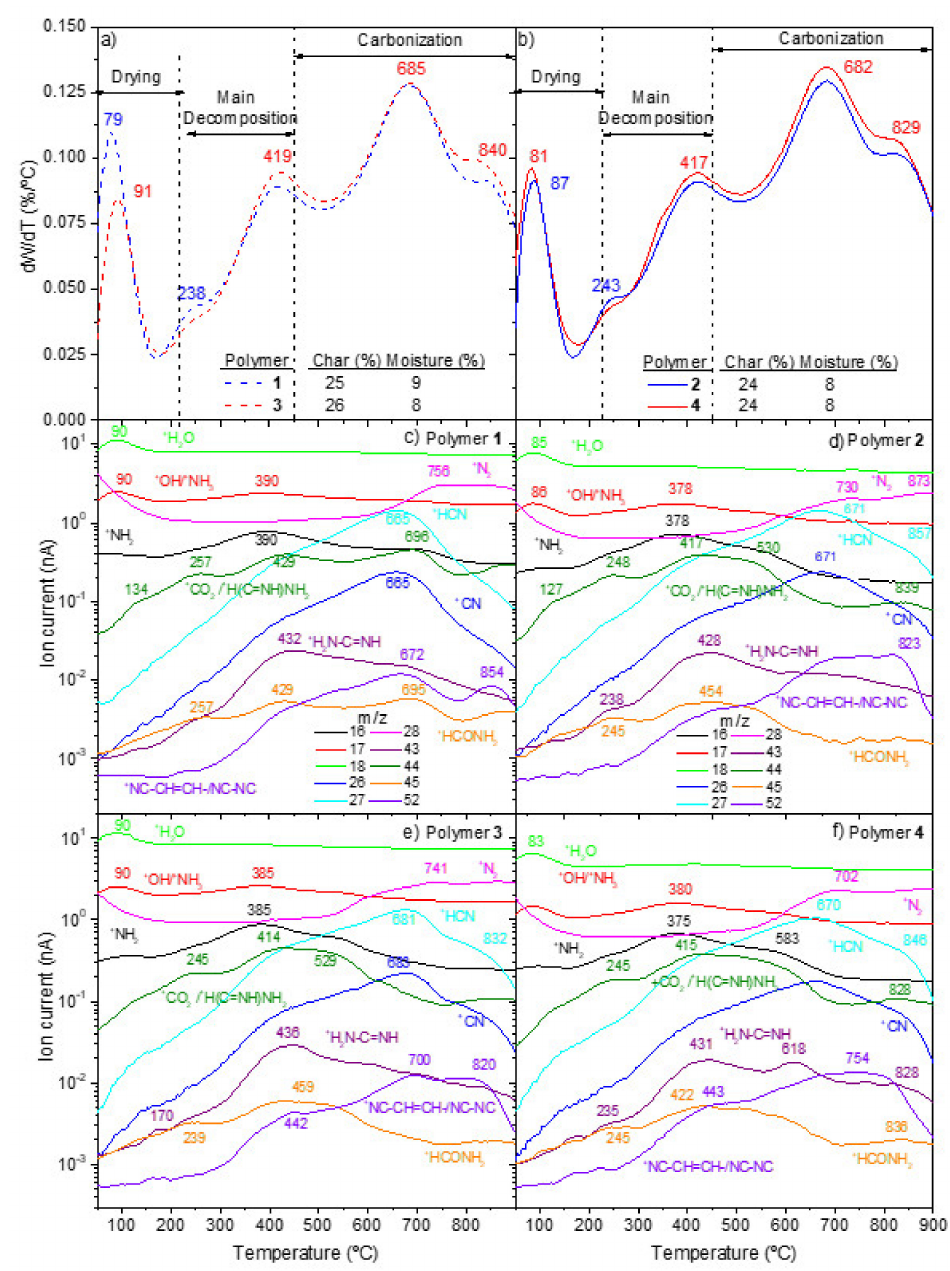
Figure 3. ( a ) DTG curves of polymers 1 and 3 and ( b ) of polymers 2 and 4 ; ( c – f ) ion intensity curves for the main fragments from polymers 1 , 2 , 3, and 4 , respectively, heated at 10 ◦ C/min and under an Ar